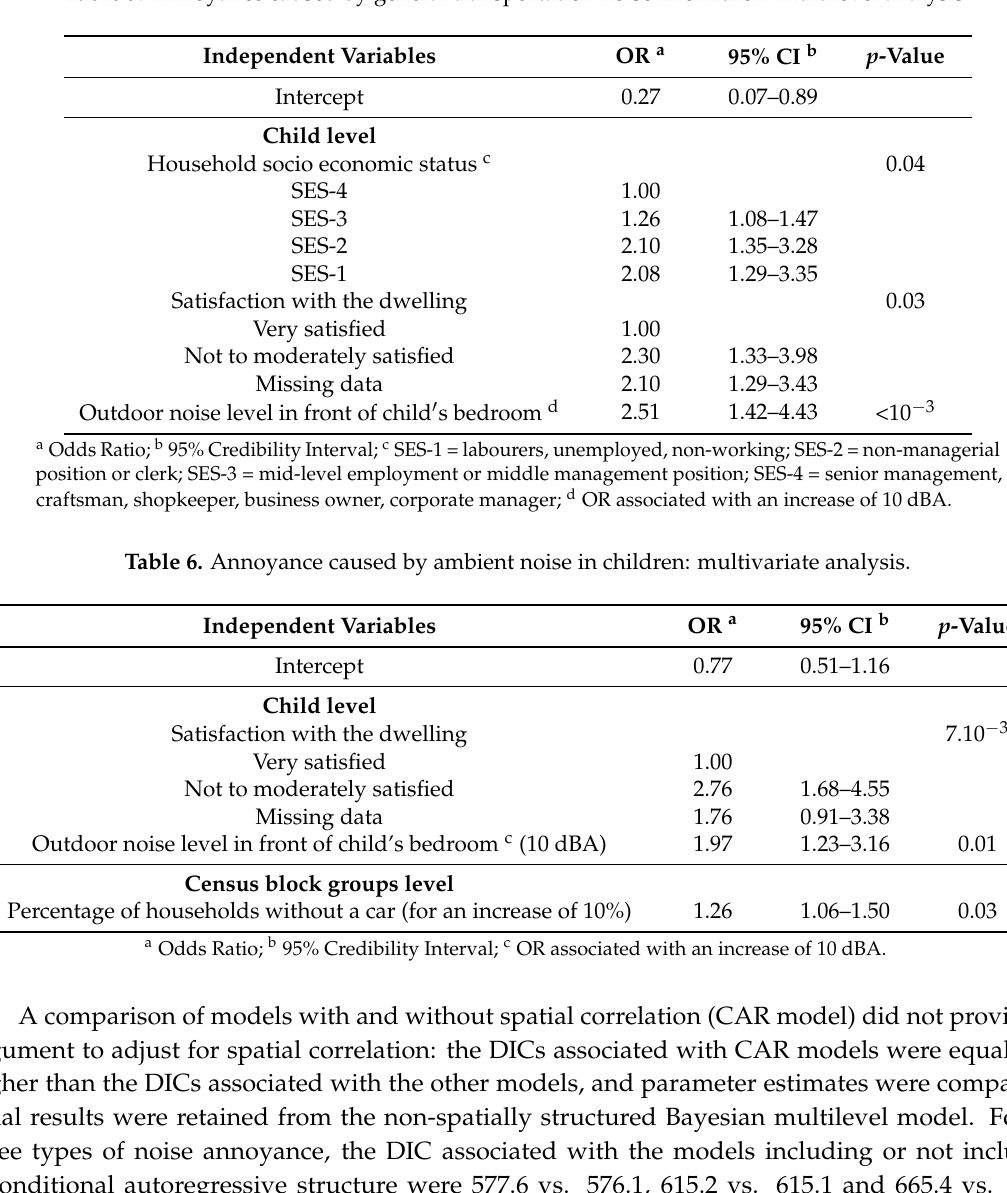
Table 5. Annoyance caused by general transportation noise in children: multilevel analysis.